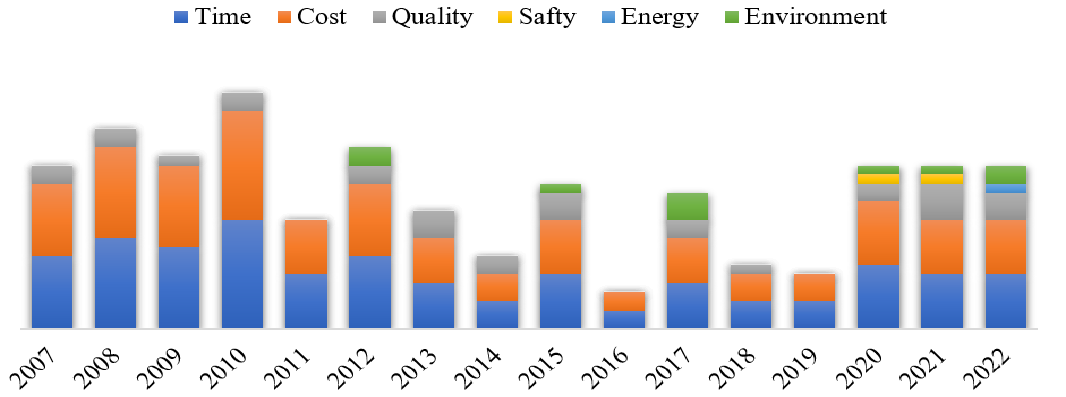
Fig. 8. Distribution of the papers on the parameters in TCTP